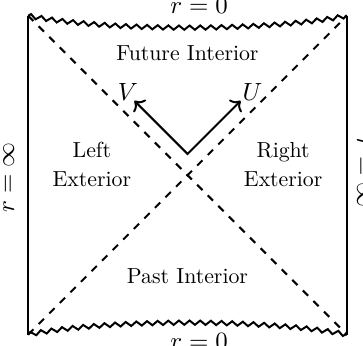
Figure 2. Penrose diagram for two-sided black holes with asymptotically AdS geometry. corresponding Penrose diagram. The two exterior regions correspond to the two Rindler wedges of